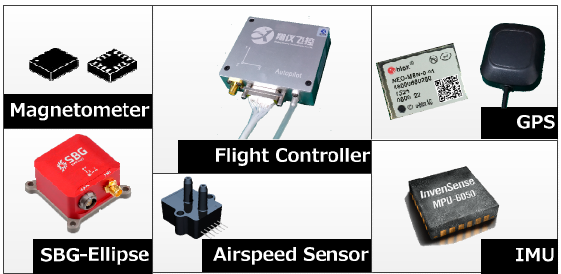
Figure 2. Low ‐ cost flight controller, GPS and (inertial measurement unit) IMU.. Figure 2. Low-cost flight controller, GPS and (inertial measurement unit)